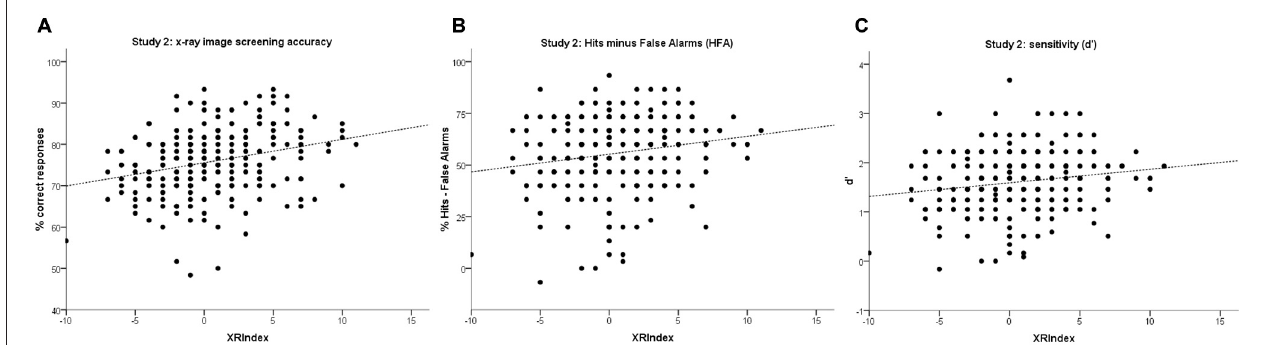
FIGURE 6 | Scatterplots with linear regression models for the XRIndex on: (A) overall accuracy (B) HFA and (C) sensitivity (d’) in Study 2. Each point may represent one or more participants.